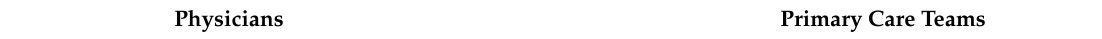
Table 4. Direct Quotes Illustrating